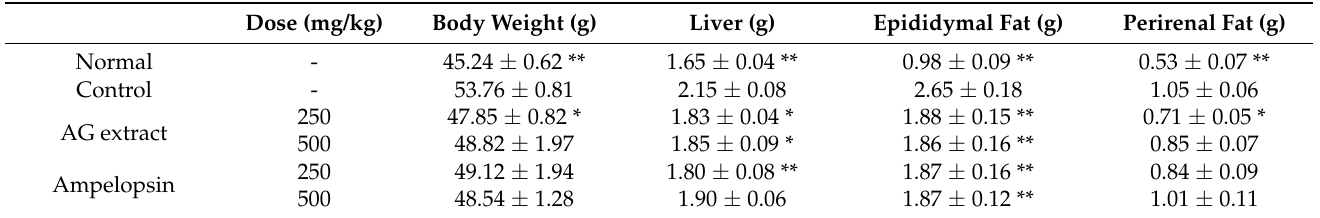
Table 1. Effects of AG extract and ampelopsin on body weights and weights of liver, epididymal and perirenal fat in HFD-fed mice.